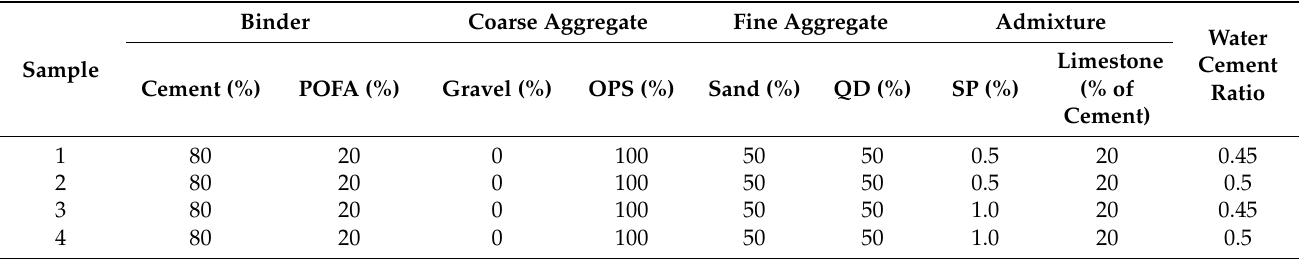
Table 3. Summary of mix design (1 cement: 1 coarse aggregate: 1 fine aggregate) and proportion distribution for Phase 1.